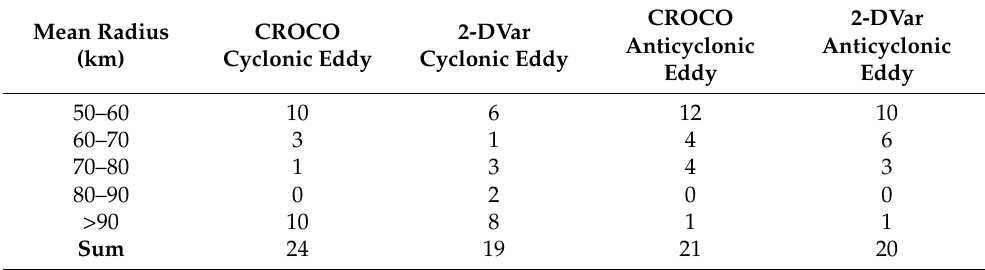
Table 2. Eddy number statistics of OSSE.